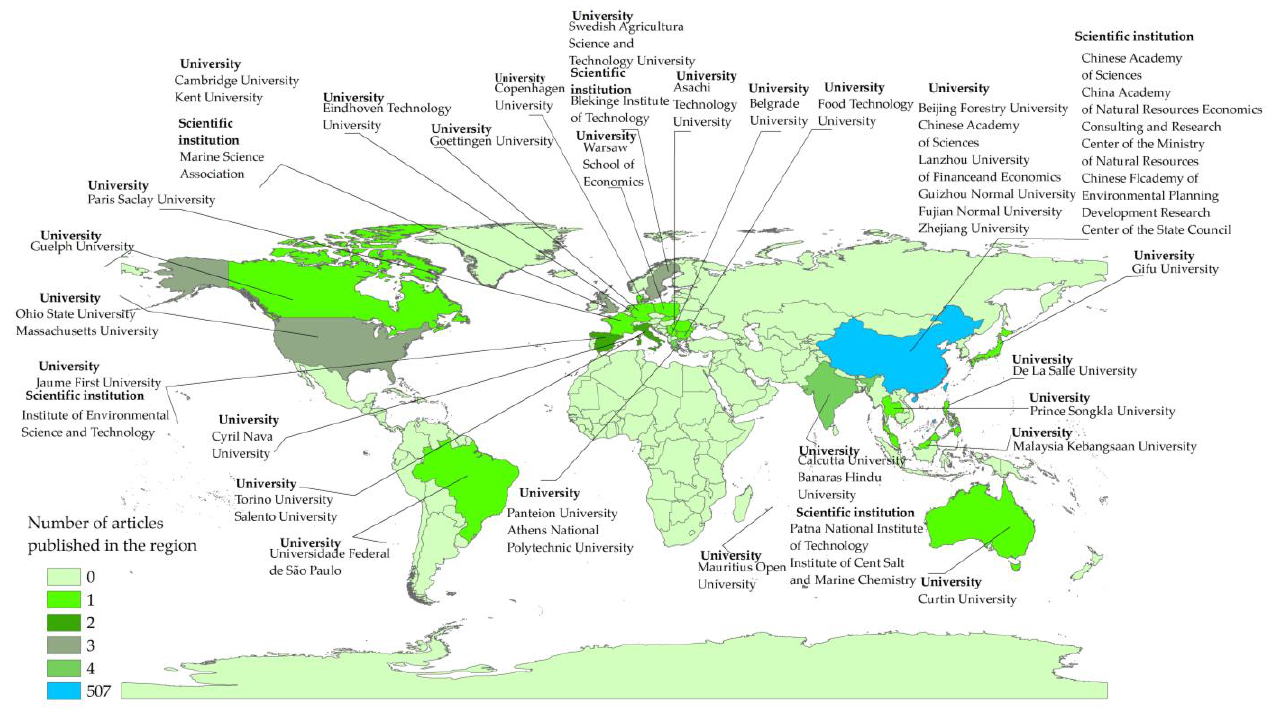
Figure 3. The breakdown of the institutions and nations described in the study (owing to space limitations, only institutions in China with more than seven publications are marked).